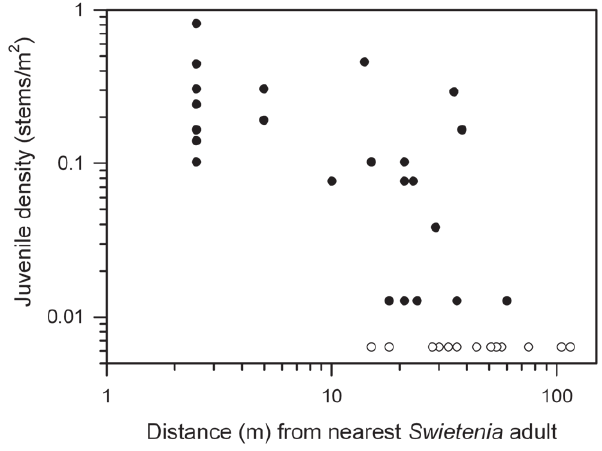
Figure 3. The relationship between density of introduced mahogany ( Swietenia ) juveniles in sampled plots ( n =37) and distance to the nearest potential parent source ( $ 20 cm dbh) in Cabrits National Park, Dominica. Note that the original counts per 78.5 m 2 plot are expressed on a per m 2 basis, and both axes are shown on a log-log scale. To show those plots with zero counts of mahogany stems (white symbols) we assigned them the same arbitrary value. The number of juveniles, including stems , 1-cm dbh but . 30- cm tall, totaled 305, and were made up almost entirely of Swietenia macrophylla (c. 97%) with very few S. mahagoni (10 juveniles). There was a significant, sigmoidal relationship between log (density + 1) and the log (distance) transformed variables (non-linear regression, F 2, 34 = 22.6, P , 0.0001, adj. r 2 =0.55, equation: y=1.41/{1 + exp[( 2 x + 1.18)/ 0.263]}.